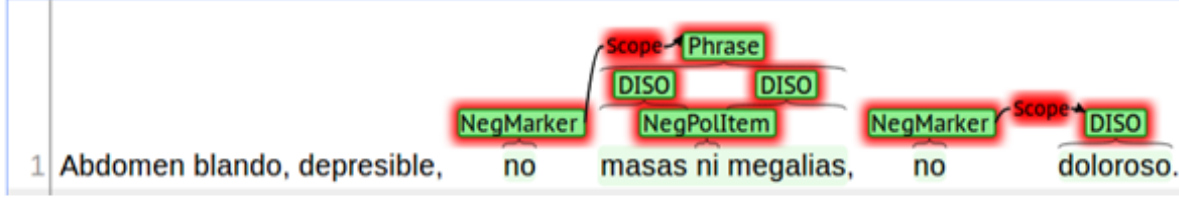
Figure 4. Examples of annotations in BRAT format over a sentence extracted from the IULA Spanish Clinical Record corpus (translation to English: soft, depressible abdomen, no masses or megalias, not painful).